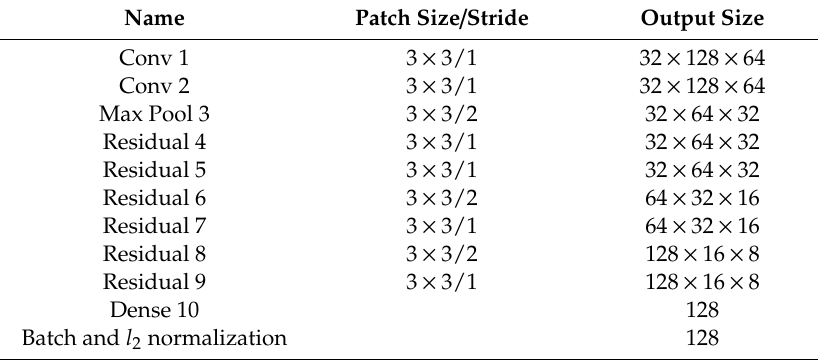
Table 4. Overview of the CNN